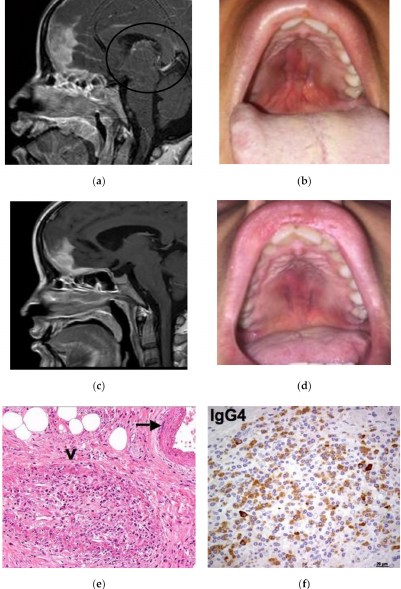
Figure 1. Patient 1: ( a ) Sagittal Magnetic Resonance Imaging (MRI ) view showing involvement of nasal septum, hard palate and pachymeninges (black circle). ( b ) The relapse of the hard palatal lesion. ( c ) Radiological and ( d ) clinical remission after rituximab therapy. ( e ) Histologic examination of the hard palatal lesion showing storiform fibrosis, plasma cell infiltrate and obliterative phlebitis (arrow). ( f ) Immunohistochemistry study evaluating IgG4 + cells.